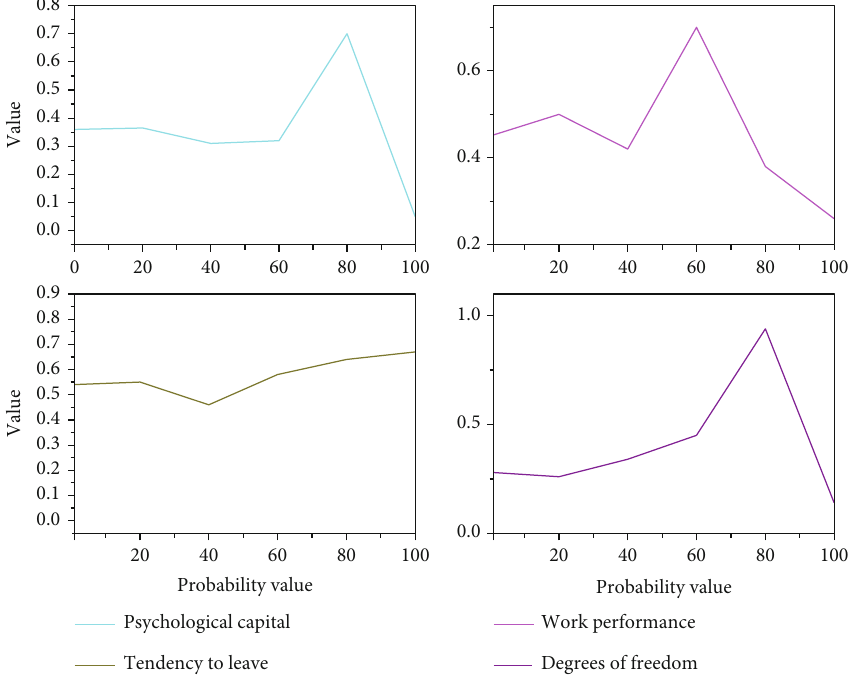
Figure 4: Multiple comparison analysis of di ff erent age variables.